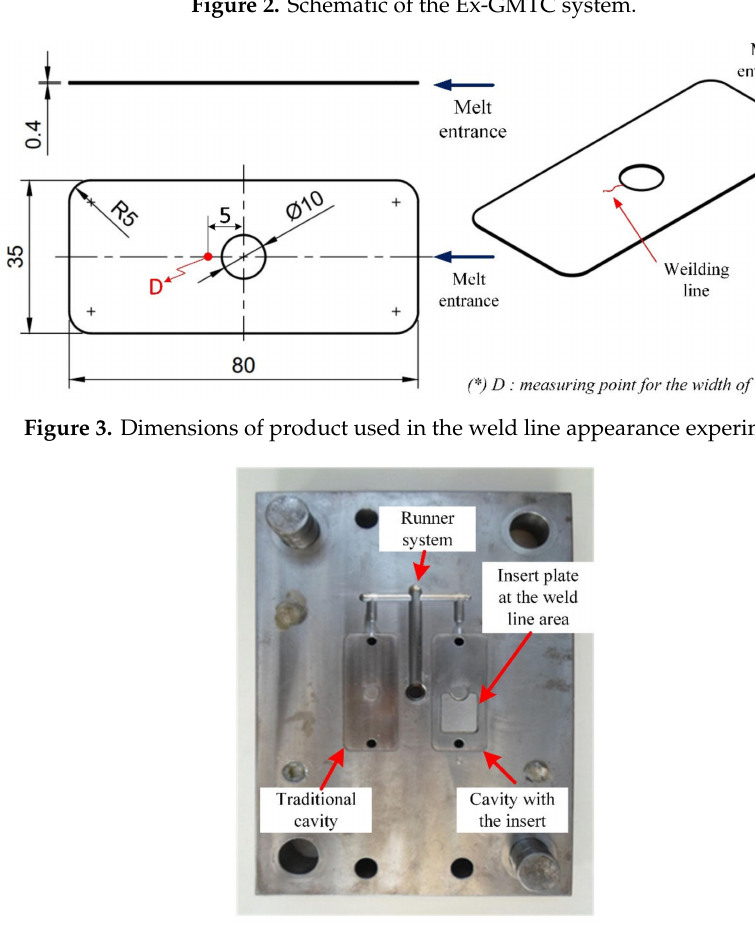
Figure 4. Mold design used in the